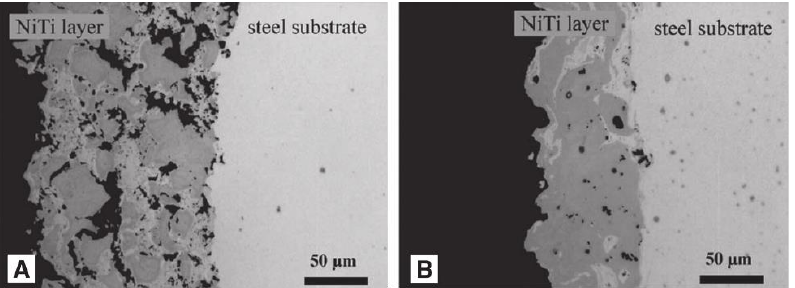
Figure 25. TiNi alloy coatings on a steel substrate produced by VPS. ( A ) The coating is porous and inhomogeneous. ( B ) The coating is less porous and exhibits a higher homogeneity (Reprinted with permission from Ref. [99]. 2002, Bram, M.).